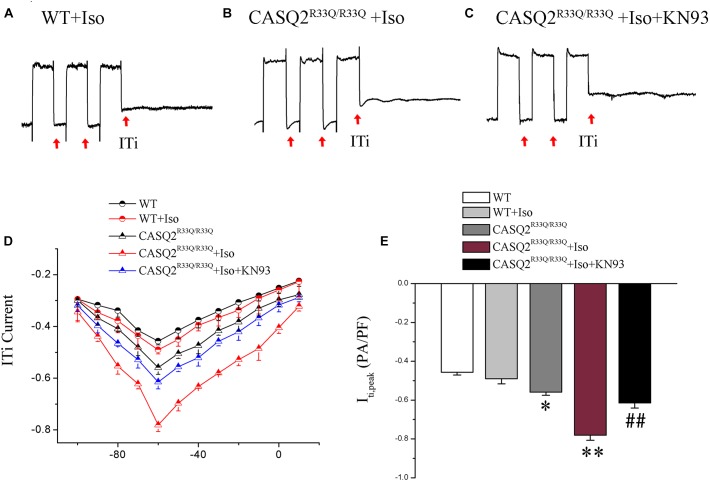
(A–C) ITi current traces from the WT and Casq2R33Q/R33Q atrial myocytes. ITi currents recorded at various membrane potentials from –100 to +10 mV after repeated repolarizing trains from –80 to +50 mV. (D) The current–voltage relation curve (I–V curve) for ITi in two groups of atrial myocytes with and without Iso. (E) Comparison of ITipeak current among groups of atrial myocytes. ∗P < 0.05 vs. WT, ∗∗P < 0.01 vs. WT. ##P < 0.01 when comparing the Iso group with the Iso plus KN93 group.